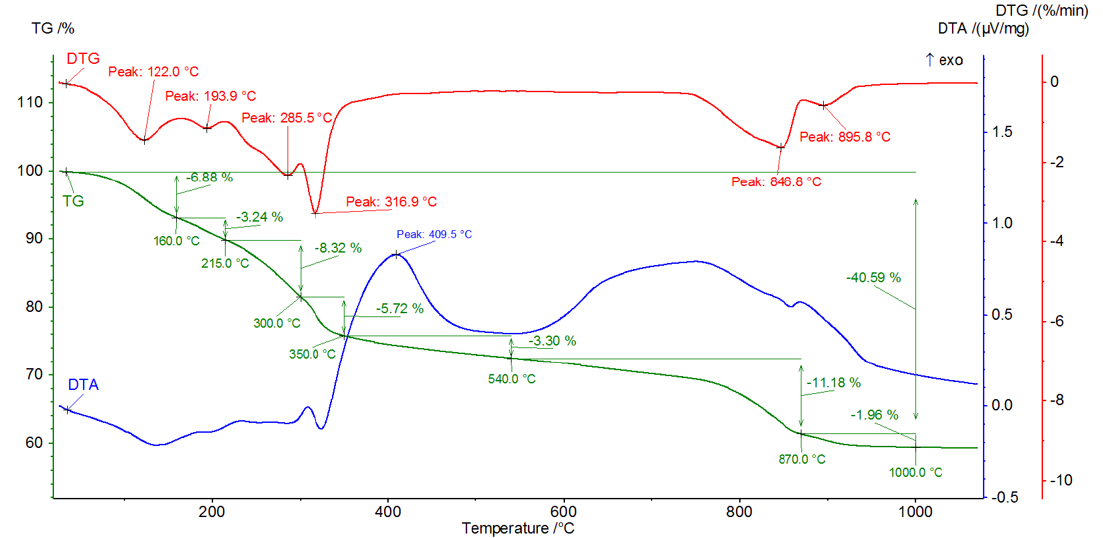
Figure 13. DTA/TG/DTG thermal curves of sample P as a function of temperature in the range 30 – 1000 °C.